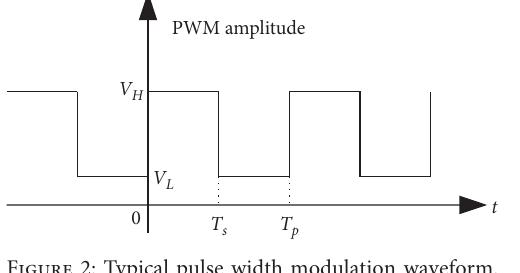
Figure 2: Typical pulse width modulation